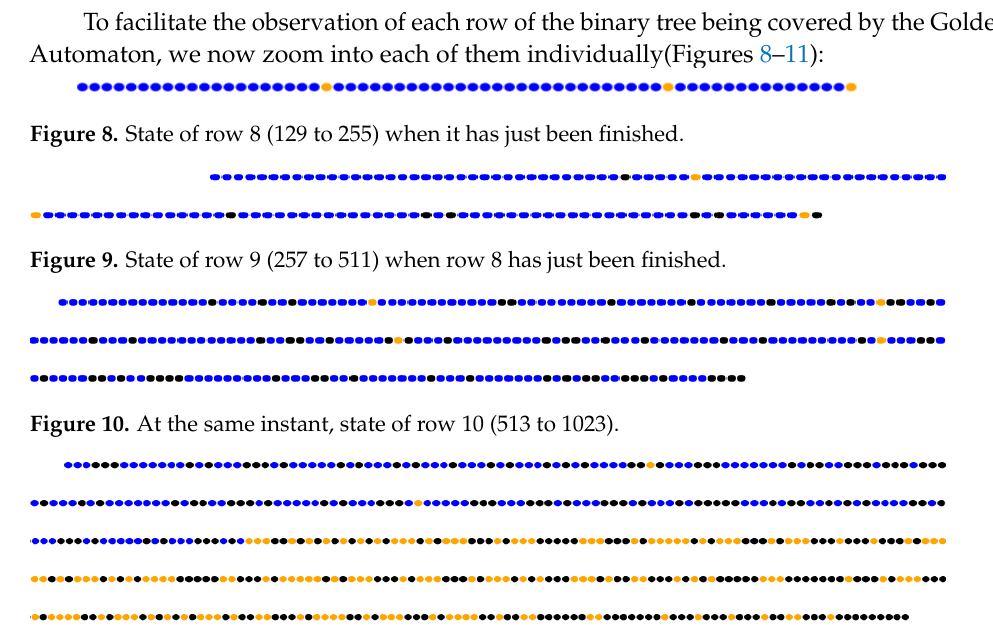
Figure 7. Case 12, instant state of the tree when the eighth row has just been completed.